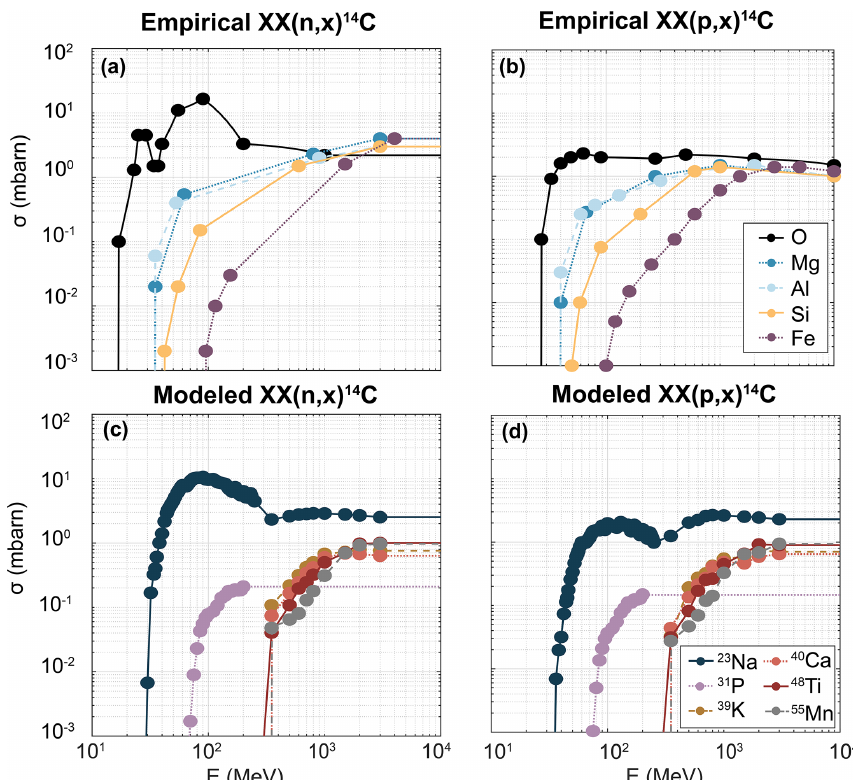
Figure 1. Empirical (Reedy, 2013) (panels a and b ) and modeled (panels c and d ) neutron and proton reaction excitation functions for in situ 14 C production from various targets. The lines are linearly interpolated between points. Note that modeled predictions for 23 Na (JENDL/HE-2007; Fukahori et al., 2002; Watanabe et al., 2011) suggest the highest production of all targets